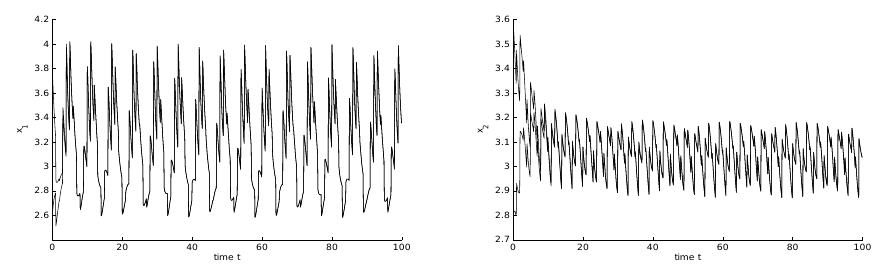
Figure 2: System (1.3) with ( ϕ 1 ( t ), ϕ 2 ( t )) = (2.6, 2.8) T and (3.8, 3.6) T for t ≤ 0 respectively.